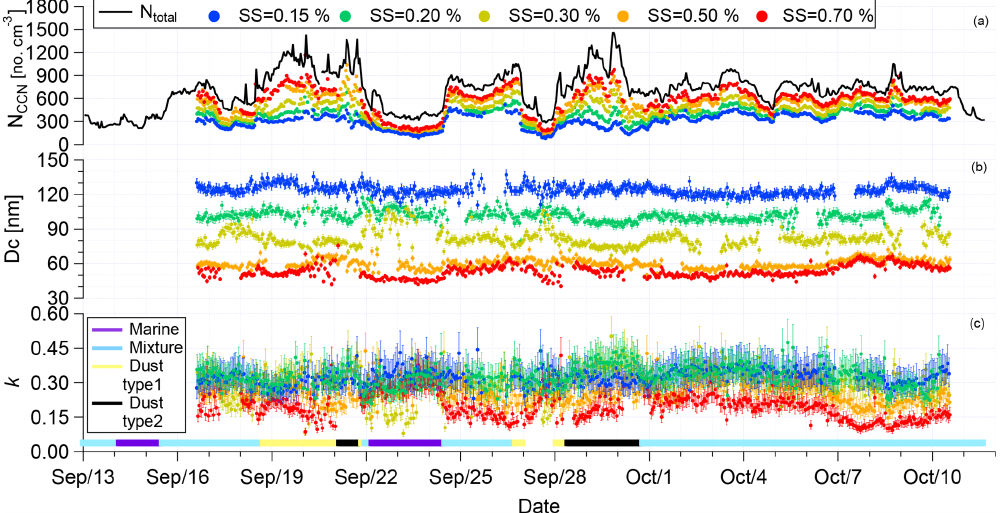
Figure 10. Time series of N CCN in (a) , d crit in (b) and κ in (c) . All of those are measured at CVAO. Error bars of d crit and κ show 1 standard deviation and 1 geometric standard deviation. The color bar in (c) indicates the times of different aerosol type periods. Table 3. Median and mean values of N CCN , d crit , κ , 1 standard deviation of d crit and 1 geometric standard deviation of κ at different